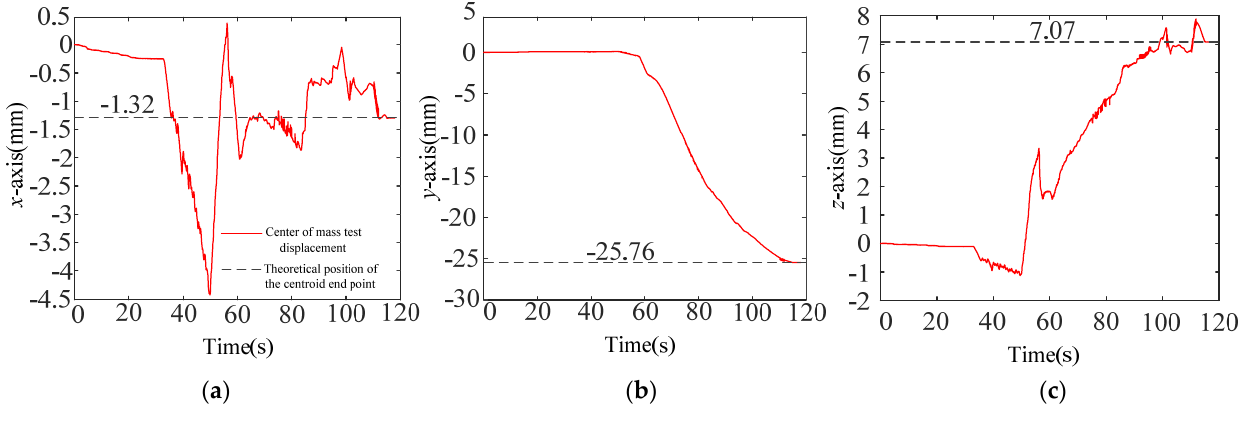
Figure 28. The displacement of the center of mass of the captured test payload in the first boundary pose (see Table 5 for details). ( a ) The x -axis displacement of the center of mass of the captured test payload in the first boundary pose; ( b ) The y -axis displacement of the center of mass of the captured test payload in the first boundary pose; ( c ) The z -axis displacement of the center of mass of the captured test payload in the first boundary pose.